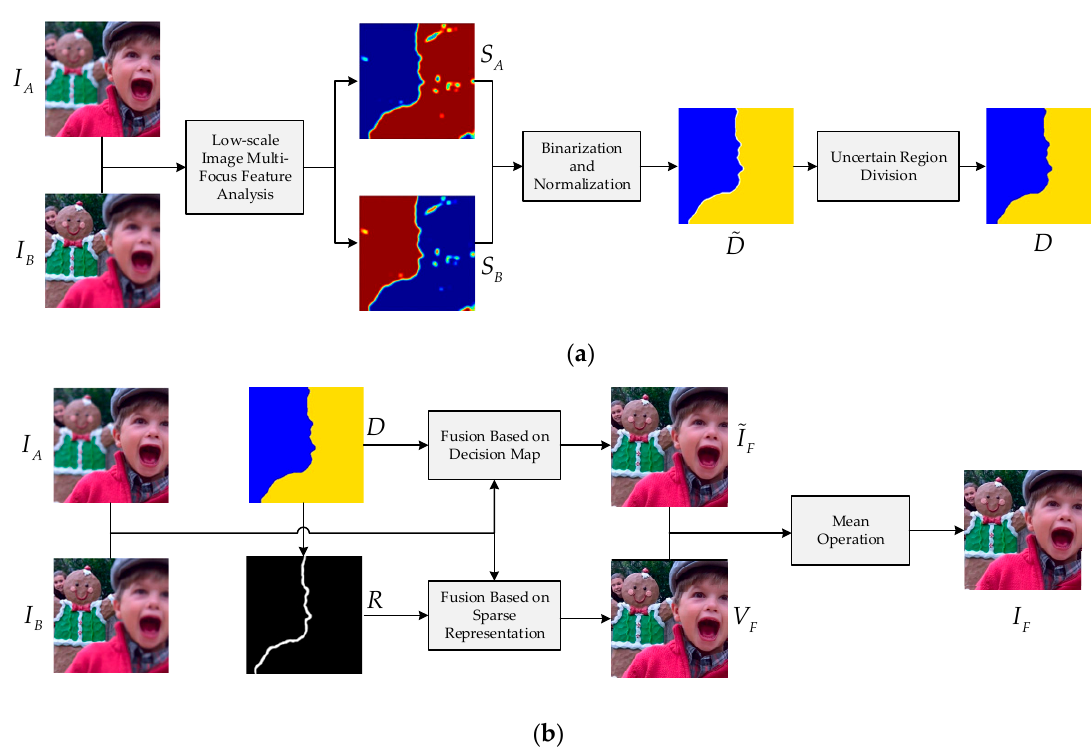
Figure 1. Framework of the proposed fusion algorithm. ( a ) The process of generating the decision map; ( b ) fusion process.